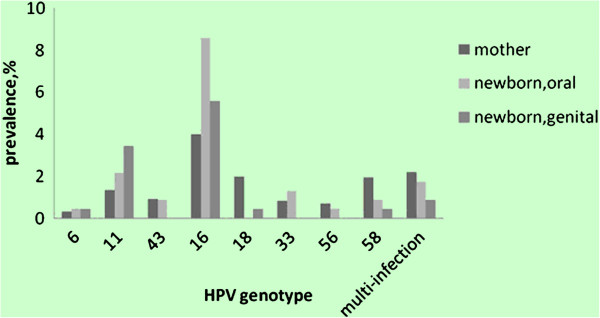
Prevalence of HPV-6, -11, -43, -16, -18, -33, -56, -58 (and multiple infections) among 422 HPV DNA-positive women and 55 HPV DNA-positive newborns.